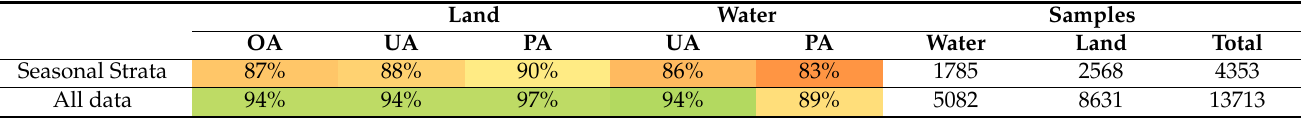
Table 2. The summarized overall classification accuracy, displayed as a heat map, across all sites and strata (cf. all data) and for the seasonal strata separately. OA = Overall accuracy, UA = User’s accuracy, PA = Producer’s